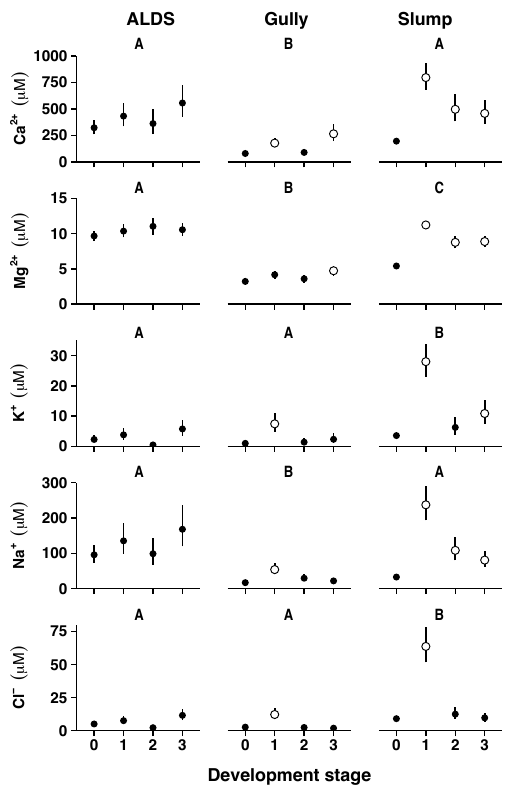
Figure 7. The relative proportion of carbon and nitrogen species Figure 6. Major ion concentrations in outflow from 22 active-layer in thermokarst outflow by feature type and development stage. See detachment slides, 19 thermo-erosion gullies, 42 thaw slumps, and Figs. 2 and 3 for estimates of error and statistical tests for each pa- 61 reference features. See Table 1 for complete definition of devel- rameter and Table 1 for complete definition of development stages: opment stages: 0, reference; 1, most active; and 3, stabilized. Note 0, reference; 1, most active; and 3, log scales for NO − and NH + . Symbology the same as Fig. 2. 3 4